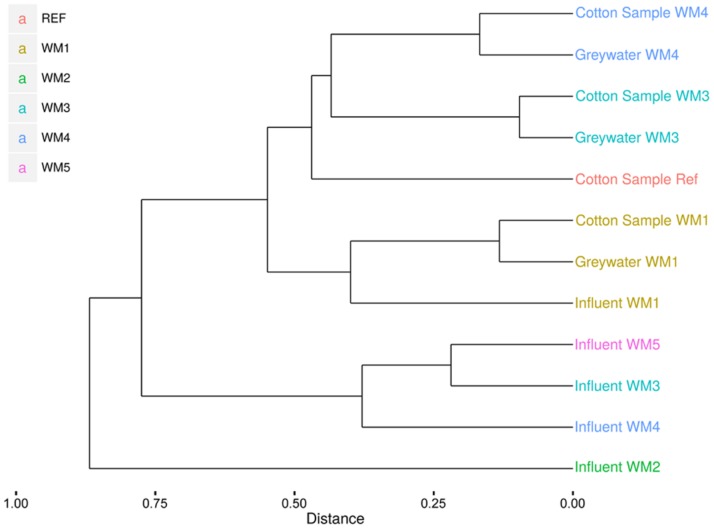
Clustering of the pyrosequencing results of the different sample types from different household WMs.Clustering according to the Sorenson index and unweighted pair group with mathematical averages dendrogram method.